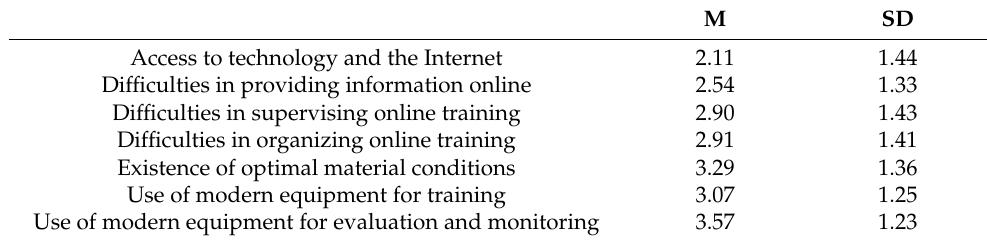
Table 2. Means and standard deviations for specific difficulties in trainers’ activity ( n =